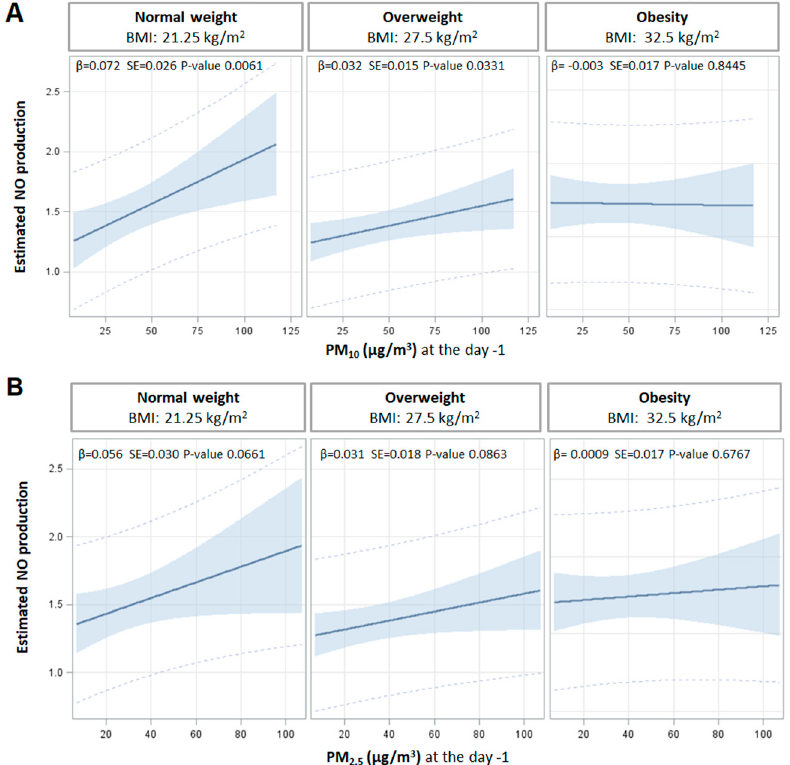
Figure 2. Interaction effect of particulate matter on NO production. Interaction effect of PM 10 ( A ) and PM 2.5 ( B ) and BMI on NO production by endothelial cells exposed to apoB-D sera. Strength of association between PM the day before the enrollment and NO production at three selected levels of BMI (normal weight 21.75 kg/m 2 , overweight 27.5 kg/m 2 , and obesity 32.5 kg/m 2 ). Adjusted β regression coefficients were reported for 10 µ g/m 3 increases in PM concentration, at each level of BMI. p -values of interaction terms PM*BMI were 0.0203 and 0.2163, respectively, for PM 10 and PM 2.5 . Linear regression models in both panels A and panel B were adjusted for age, gender, smoking habit, HDL-C, triglycerides, IL-8, and apparent temperature on the day of recruitment.